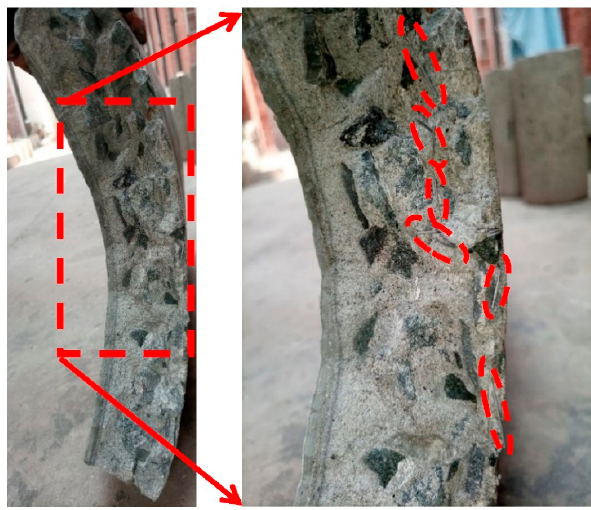
Figure 19. Fracture surface of the tested concrete pipe incorporating steel fibers (Location of steel fibers mentioned at outer edge enclosed in red dashed lines).